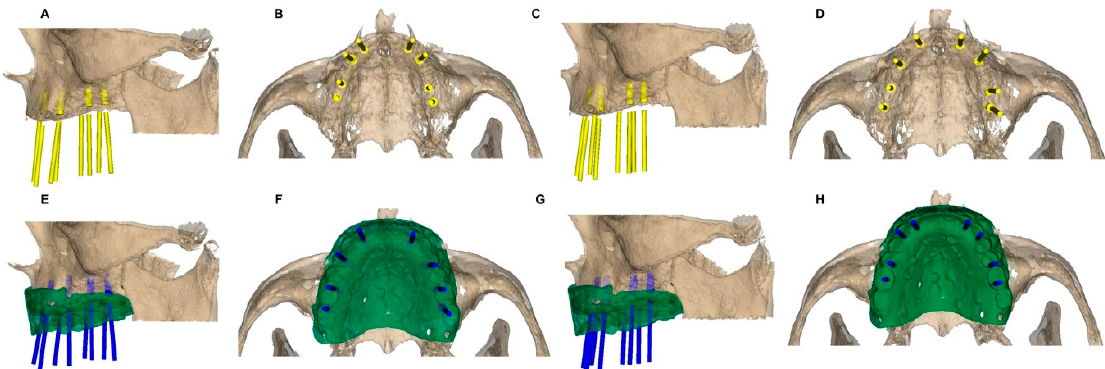
Figure 1. Dental implant planning before ( A – D ) and after (E – H ) using the digital mock-up in 5–10 years’ experience ( A , B , E , F ) and no experience ( C , D , G , H ) study